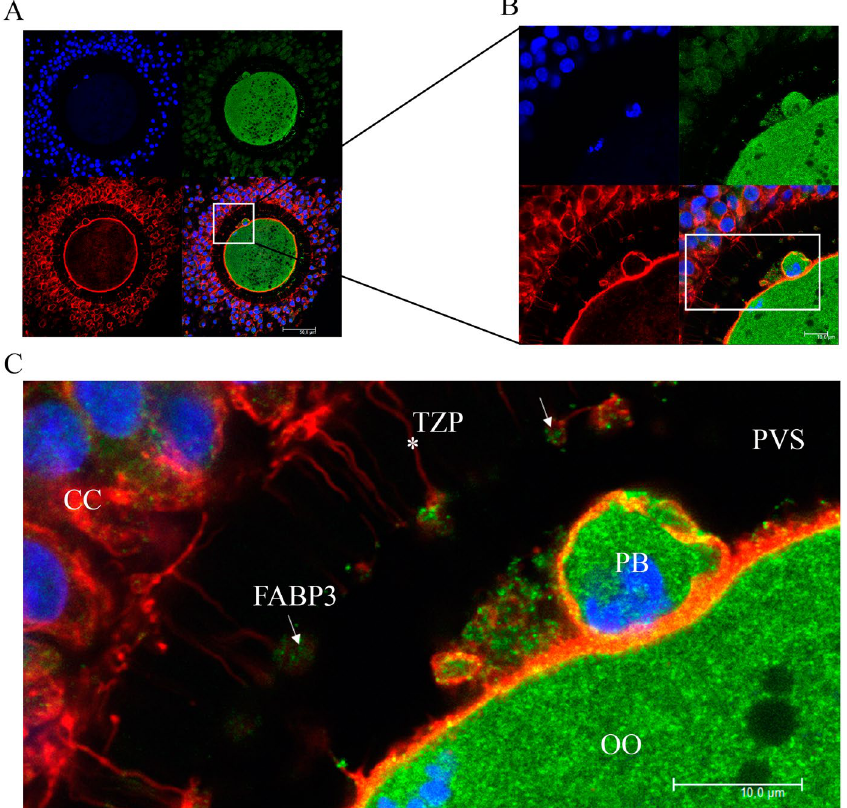
Figure 5. Confocal microscopic analysis of cumulus-oocytes complexes (COCs) after 18 h of IVM. ( A ) Confocal photomicrographs of immunodetection of fatty acid binding protein 3 (FABP3) in tranzonal projections (TZPs) in 18-h matured COCs. ( B ) Photomicrograph showing a detailed view of the COC using a 63x objective and zoomed 3.5x. ( C ) The digital zoom showing the details of the terminal portions of the TZPs disconnected from the ooplasm; FABP3 are immunolocalized at the terminal portion of the TZPs. FABP3 is immunostained using 488 Alexa Fluor (green); TZPs (actin) are stained with Alexa Fluor 647 phalloidin (red); nuclei are stained with DAPI (blue). Photomicrographs were obtained in 63 x objective ( A ) and in 63 x objective zoomed 3.5 x ( B ). Digital zoom ( C ) showing a few FABP3 molecules (arrow) in the terminal portion of TZPs (asterisk) and the perivetellin space (PVS) between oocyte (OO) and zona pellucida. (CC = cumulus cells; PB = polar body). A total of 15 COCs in vitro -matured for 18 hours were analysed and showed similar pattern; 6 additional COCs are shown in Supplementary Fig.